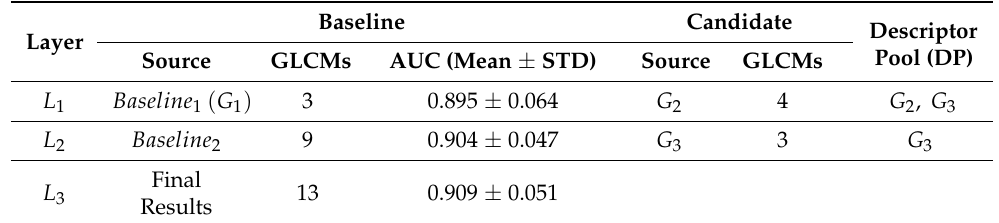
Table 7. The results of MG-CNN over the polyp dataset. Descriptor pool represents the current candidates and its sequence in each layer. Baseline 2 is a new descriptor generated by the baselines and the complements of their previous